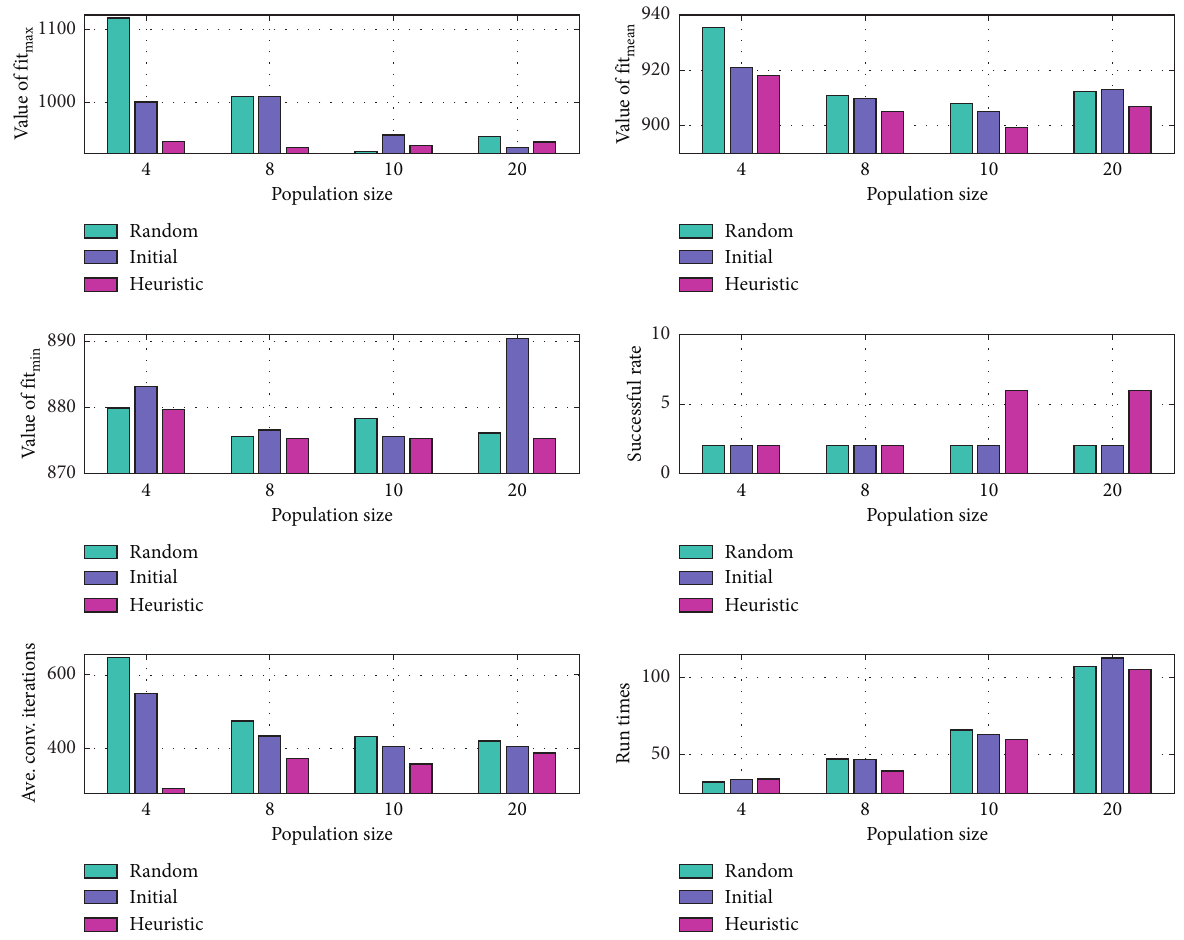
Figure 15: Comparisons among three initialization methods in terms of fit